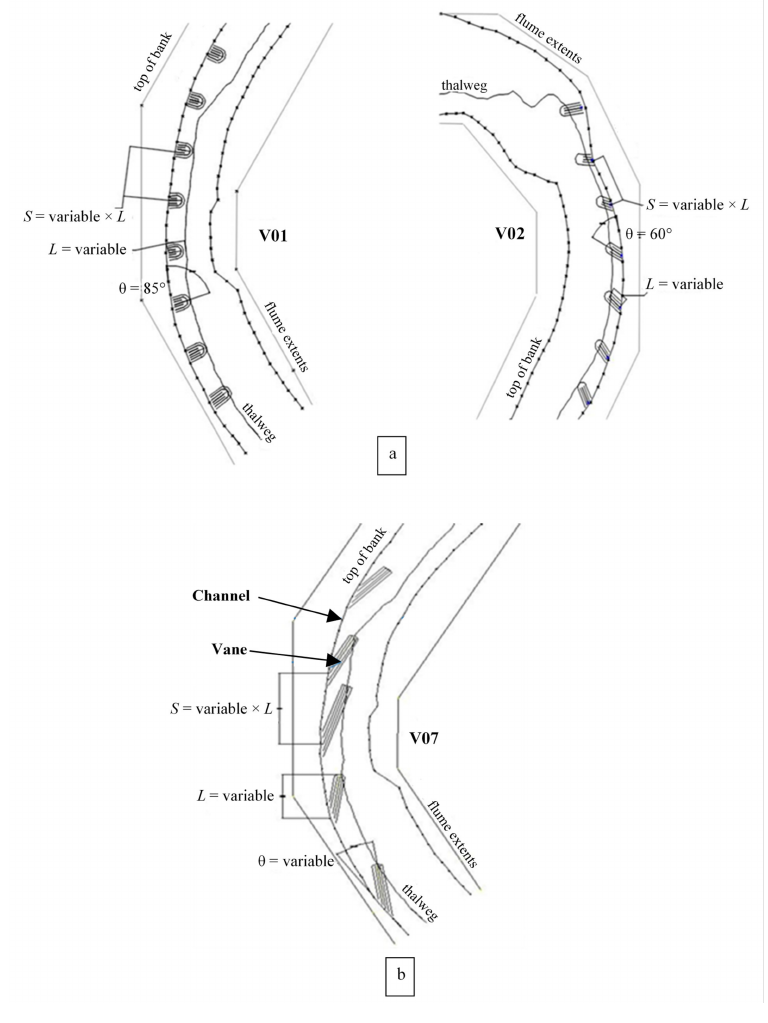
Figure 5. Design schematics of rock vane configurations V01, V02, ( a ) and V07 ( b ) the Natural Resources Conservation Service (NCRS) design configurations